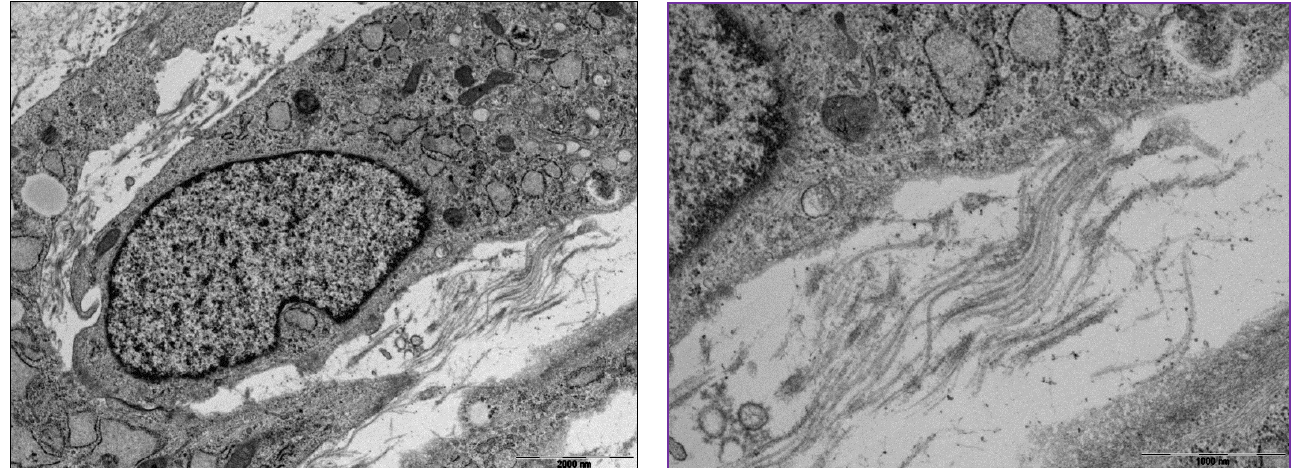
Figure 7. Transmission electron microscopy of differentiated mesenchymal stem cells (MSCs) into chondrocytes and extracellular collagen fibrils (box). ( Left ) Scale bar, 2000 nm; ( Right ) scale bar, 1000 nm.